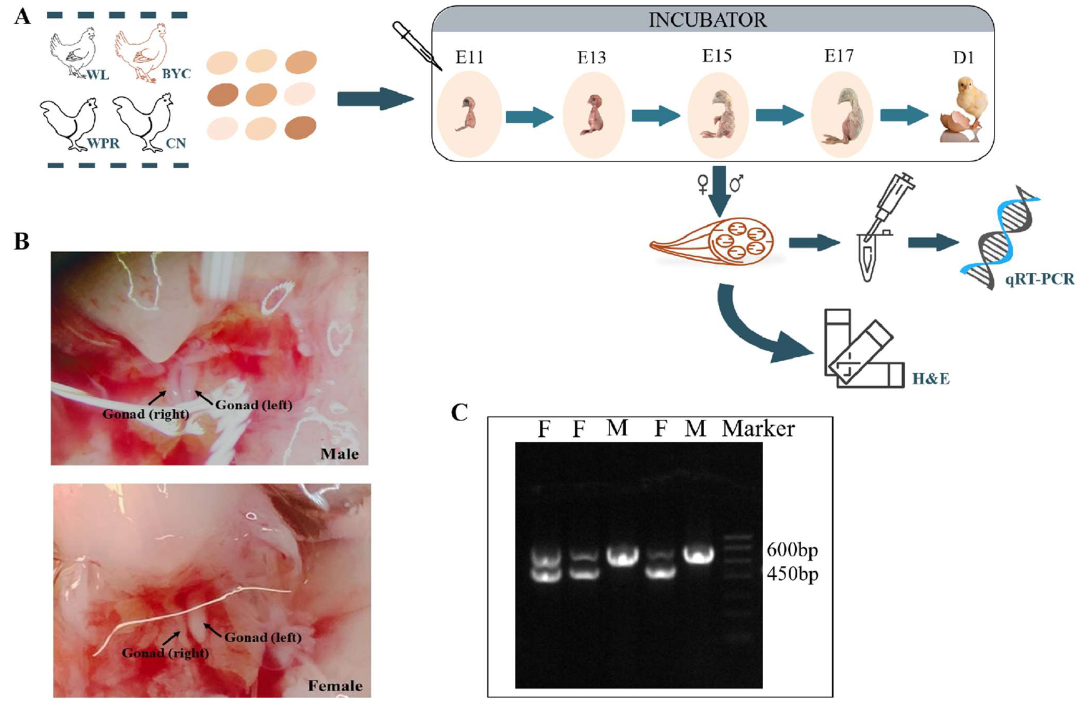
Figure 5. Experimental design and sex determination. ( A ) Experimental design. In this study, four chicken breeds and five embryonic important time points were selected to explore the expression levels of three muscle-related genes in pectoral muscle and thigh muscle. In addition, the H&E slices were made for the observation of the histomorphology of myofibers. ( B ) Graphical representation of different sexes. For males, both sides of the gonads were the same size; for females, the left side of the gonads was larger than the right side. ( C ) Reconfirmation of sexes by gel mapping. For males (M), one band (600 bp) was visible; for females (F), two bands (600 bp and 450 bp) were visible.